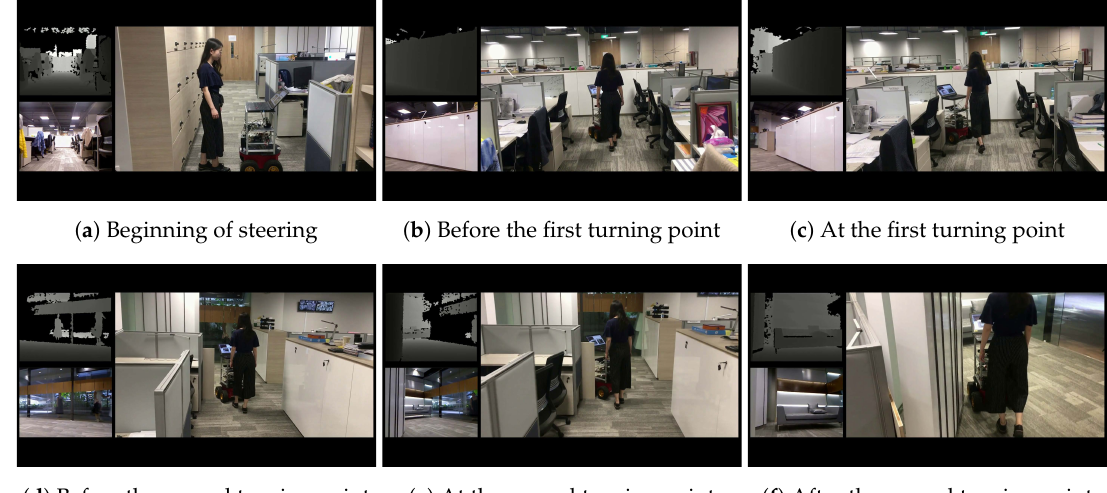
Figure 7. Intermediate steps of the first real-world experiment. In this experiment, the BND-DDQN model is evaluated in a cluttered office environment. For each step, the third-person view is shown on the right and the corresponding depth image and first-person view are displayed in the top and bottom left corners,